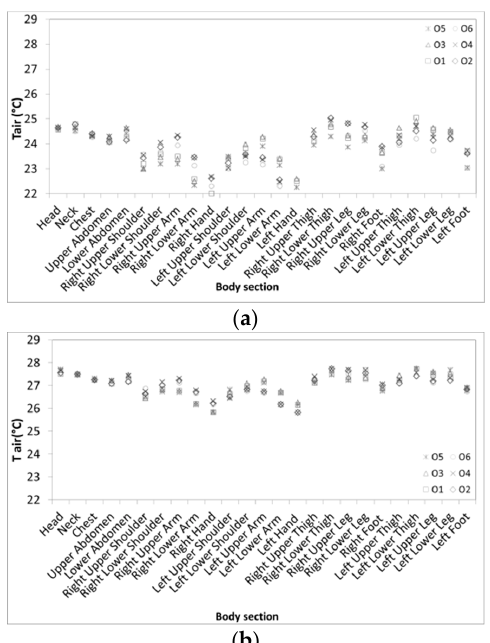
Figure 16. Mean air temperature value around the 25 human body sections of 6 occupants, for an inlet air temperature of ( a ) 20 °C and ( b ) 24 °C.